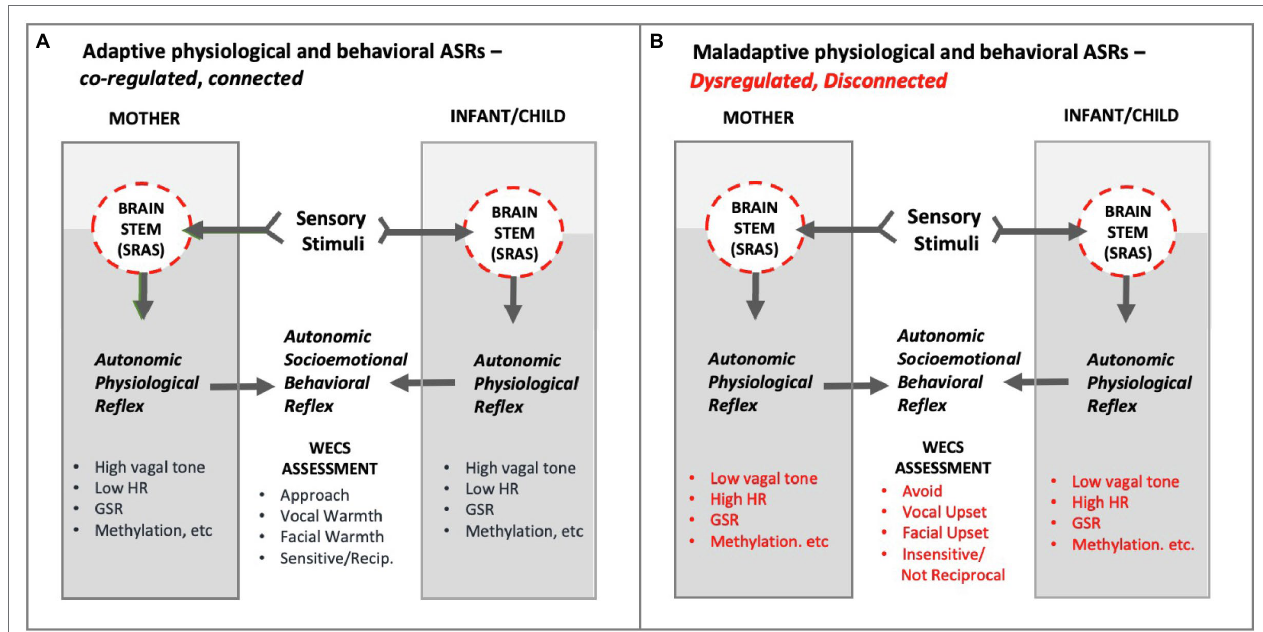
FIGURE 12 | Conceptual diagram of hypothetical Adaptive and Maladaptive Autonomic Socioemotional Reflexes (ASRs) in mother and infant/child . As shown, the ASRs manifest behaviorally and physiologically. The mutual behavioral reflex component can be measured via the WECS. The mutual physiological reflex component can be measured by vagal tone, heart rate (HR), galvanic skin response (GSR), methylation, E/I balance, inflammatory/anti-inflammatory, etc. Panel A illustrates adaptive autonomic socioemotional reflexes . Panel B illustrates maladaptive autonomic socioemotional reflexes . The two conditional states correspond to long observed binary behaviors, such as approach/avoidance, and corresponding reports of binary physiology associated with behavior, such as those listed above. Abbrev: SRAS, systemic reticular activating system; WECS, Welch Emotional Connection Screen; HR, heart rate; GSR, galvanic skin response; E/I balance, excitatory-inhibitory